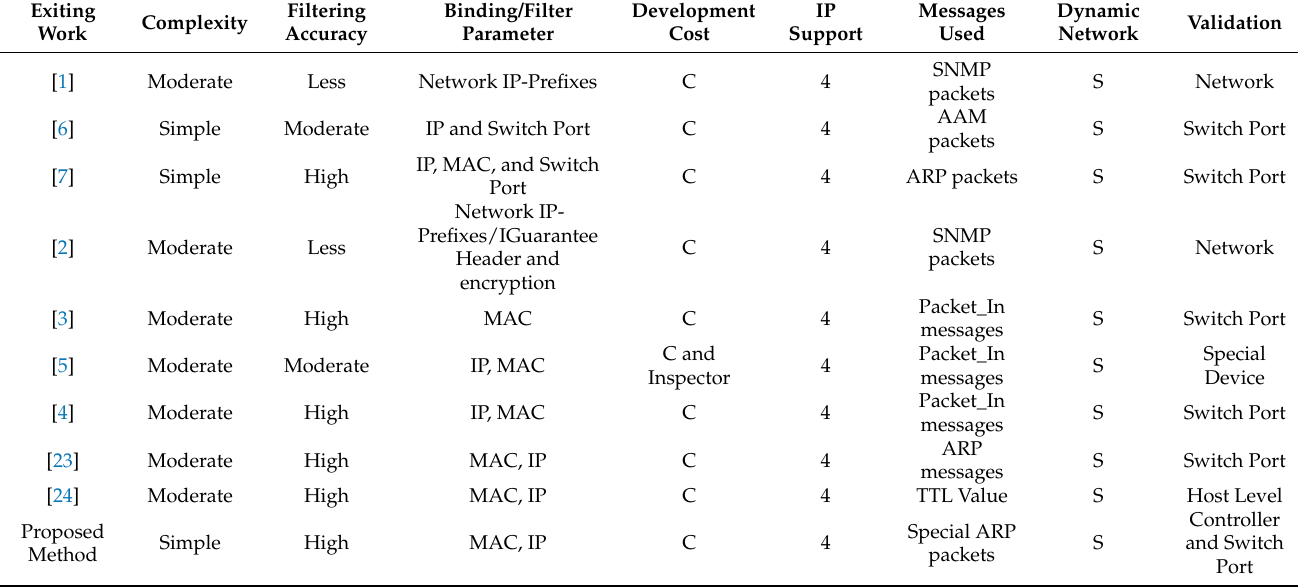
Table 7. Performance and Comparative analysis of SDN Source Address Prevention